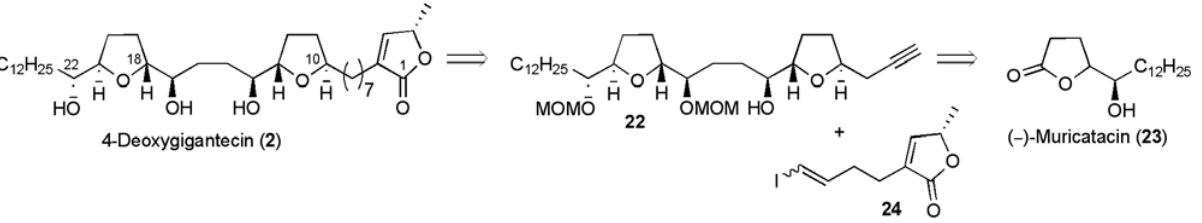
Figure 7. Overview of Makabe’s approach to 4-deoxygigantecin ( 2